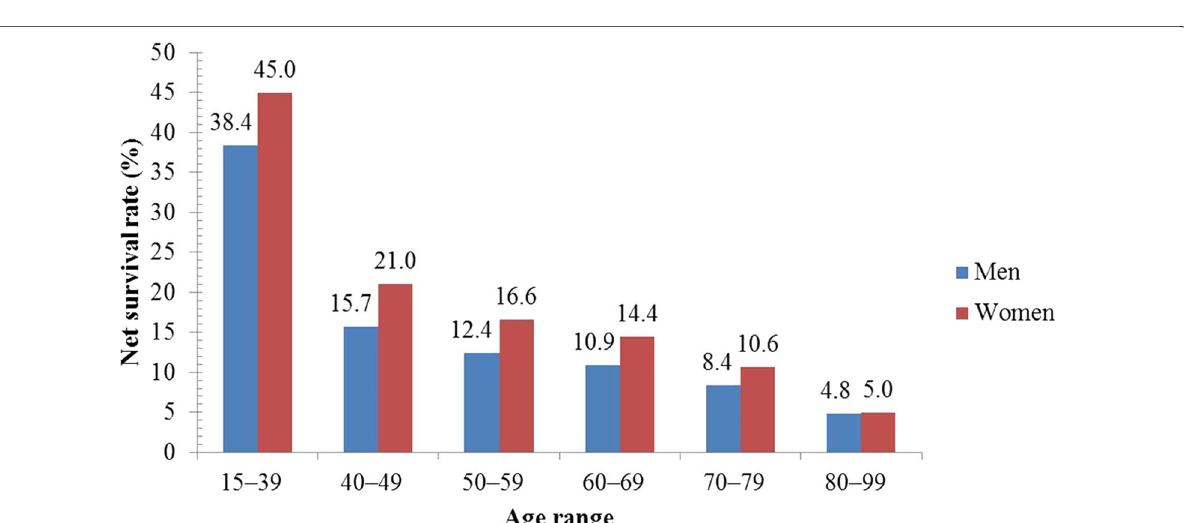
Fig. 4 Five-year net survival rate of lung cancer patients by age in the United Kingdom (UK). During the period 2007–2011, the 5-year age-stand- ardized net survival rates of men with lung cancer gradually decreased from 38.4% to 4.8%; for women, it decreased from 45.0% to 5.0%. This shows that the 5-year survival for lung cancer is highest in the youngest men and women and decreases with increasing